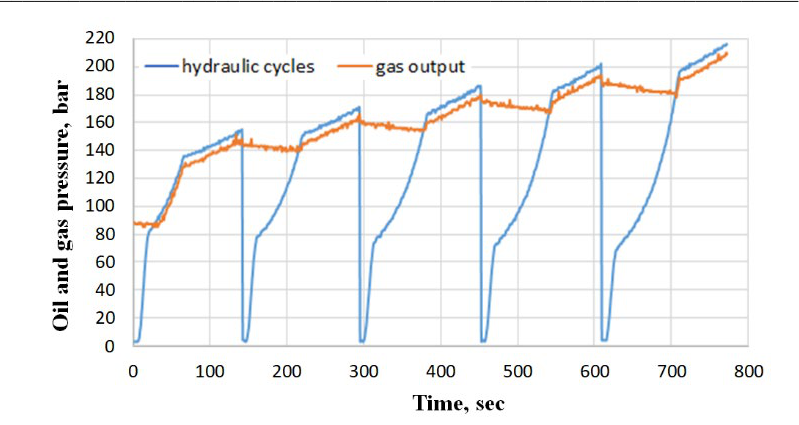
Fig. 4. Boosting stage of fuelling a target